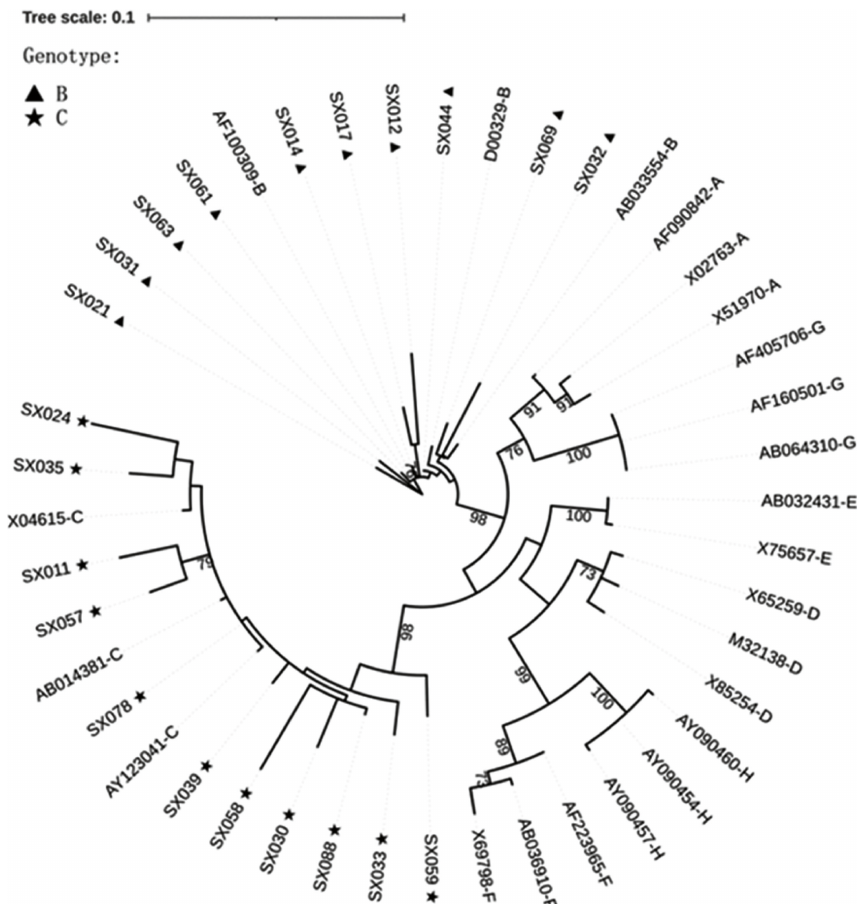
Figure 1: Neighbor-joining phylogenetic tree analysis of OBI S genetic sequences. Analyses were based on 21S region sequences from blood donors with OBI. Arabic numerals were suffixed with SX represented samples from OBI blood donors; others were reference sequences for multiple genotypes (A through H) from